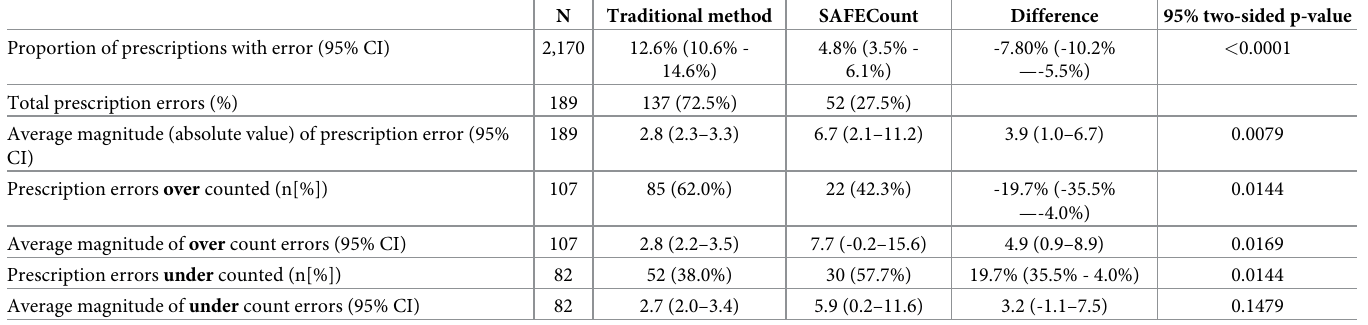
Table 4. Accuracy of pill counting using traditional method versus